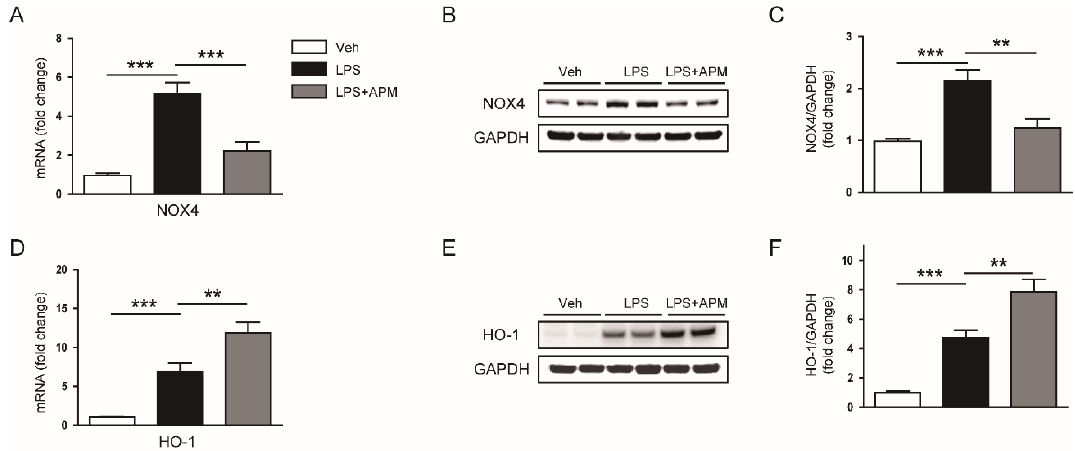
Figure 6. Effect of apamin on nicotinamide adenine dinucleotide phosphate oxidase 4 (NOX4) and heme oxygenase-1 (HO-1) expression. ( A ) The mRNA expression of NOX4. ( B ) Immunoblotting of NOX4. ( C ) Quantification of immunoblot for NOX4. ( D ) The mRNA expression of HO-1. ( E ) Immunoblotting of HO-1. ( F ) Quantification of immunoblot for HO-1. n = 8 per each group. ** p < 0.01 and *** p < 0.001.